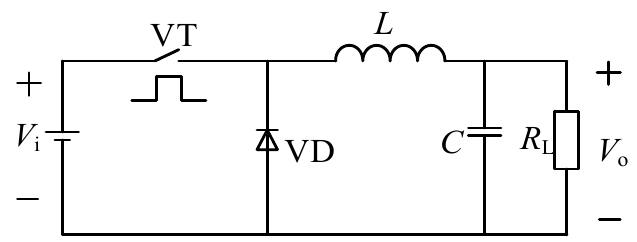
Figure 1. Schematic diagram of a Buck converter.